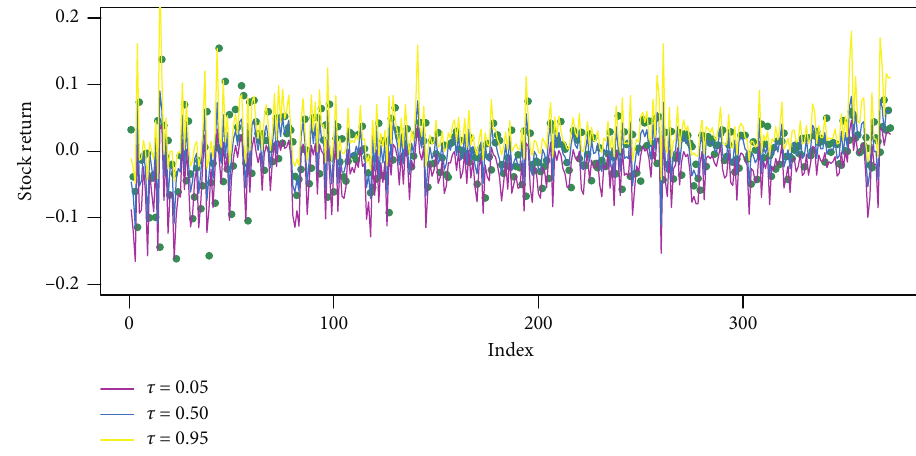
Figure 1: Comparison of fitting effects of different subloci ( τ � 0 . 05 , 0 . 50 , 0 .